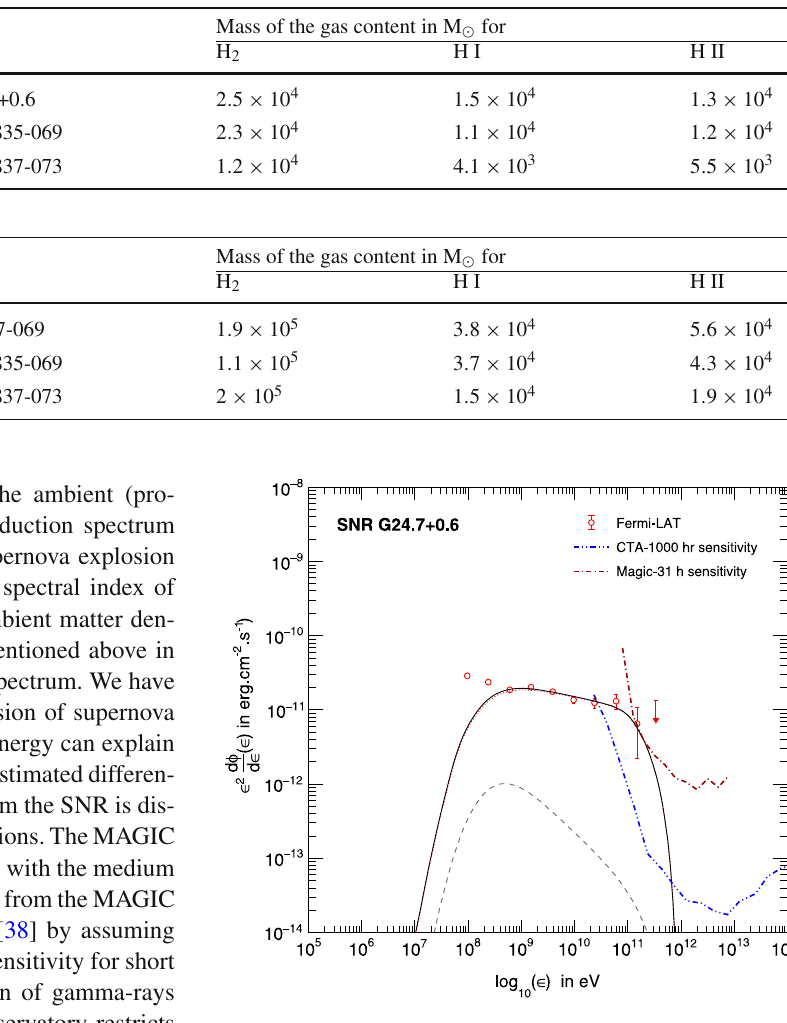
Fig. 2 The estimated differential energy spectrum of gamma-rays reaching the Earth from the SNR G24.7+0.6. The red dotted line repre- sents the gamma-ray flux produced due to interaction of SNR acceler- ated cosmic rays with the ambient matter of the SNR. The gray dotted line denotes the background gamma ray flux from the SNR due to inter- action the cosmic rays galactic background with SNR material. The black continuous line represents the estimated overall differential EM SED from the SNR G24.7+0.6. The blue dash-double-dotted and brown dash-single-dotted lines represent the detection sensitivity of the CTA detector for 1000 h and the MAGIC detector for 31 h,